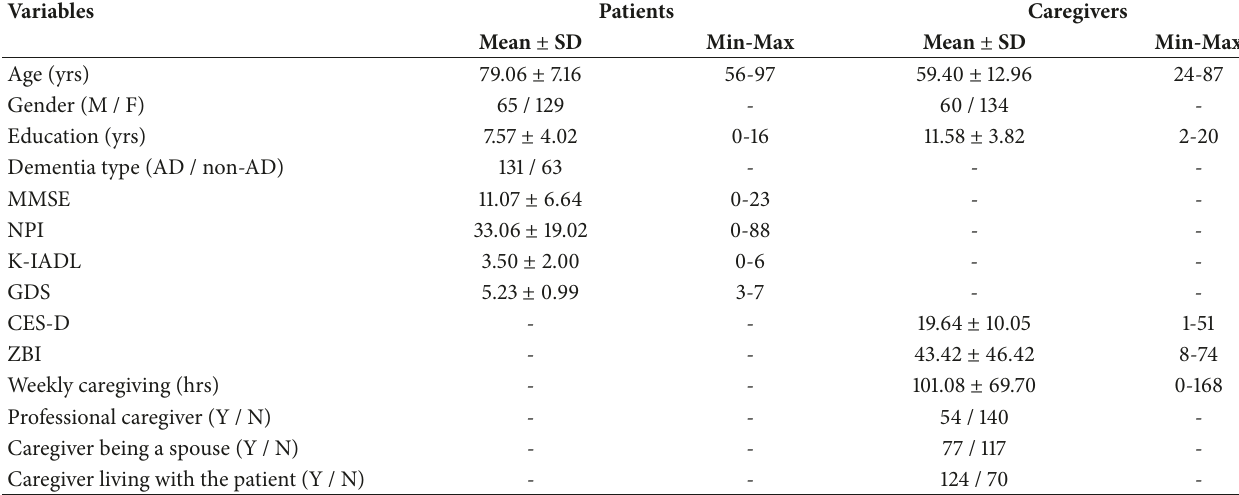
Table 1: Demographic, clinical, and psychometric characteristics for the samples of patients with